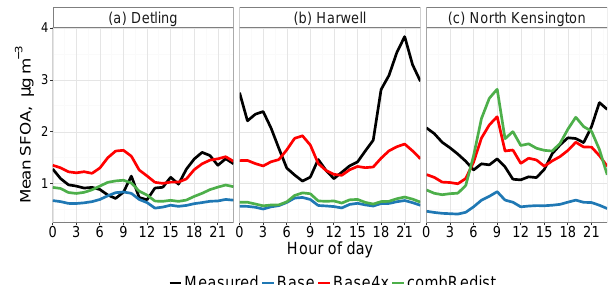
Figure 7. Hourly averaged diurnal profiles of modelled and mea- sured SFOA concentrations at the (a) Detling, (b) Harwell, and (c) North Kensington measurement sites, winter IOP 2012.